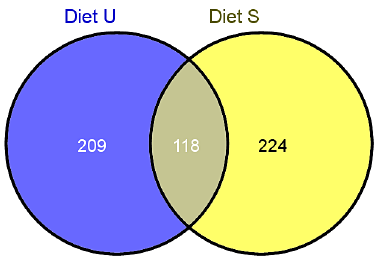
Figure 2. Number of transcripts significantly different ex- pressed in rainbow trout fed Diet U and S. Venn diagram [48]. Based on isotigs assembled from more than 50 read with human IDs (IPA readable). Diet U: 209 uniquely mapped transcripts from a total of 448 molecules. Diet S: 224 uniquely mapped transcripts from a total of 533